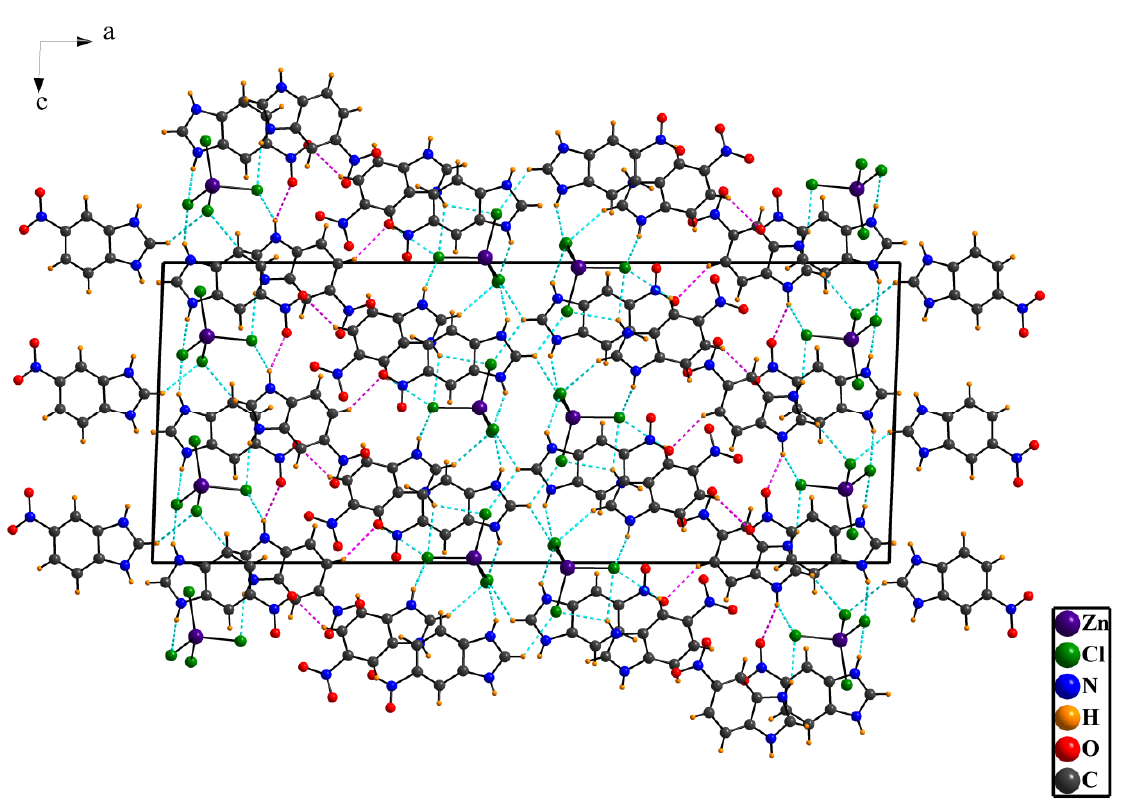
Figure 2. Projection in the plane (a,c) of the atomic arrangement of (C 7 H 6 N 3 O 2 ) 2 [ZnCl 4 ]. The red and cyan lines correspond to the H-bonds.